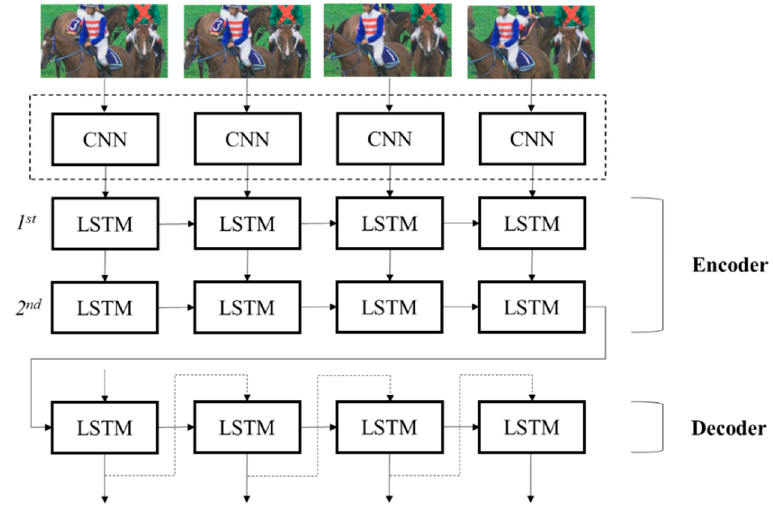
Figure 6. Proposed network when only one feature is available.